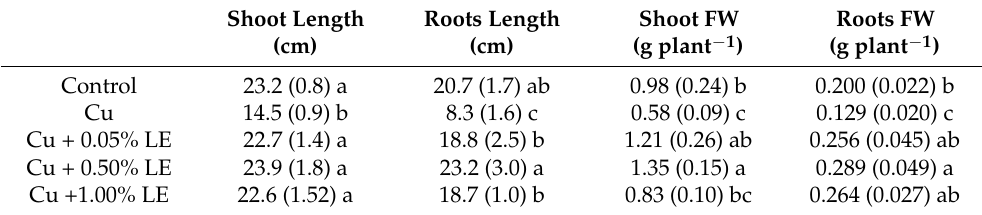
Table 1. Shoot and root length and fresh weight (FW) recorded in control maize, samples treated with Cu alone and in combination with 0.05%, 0.50% and 1.00% LE.